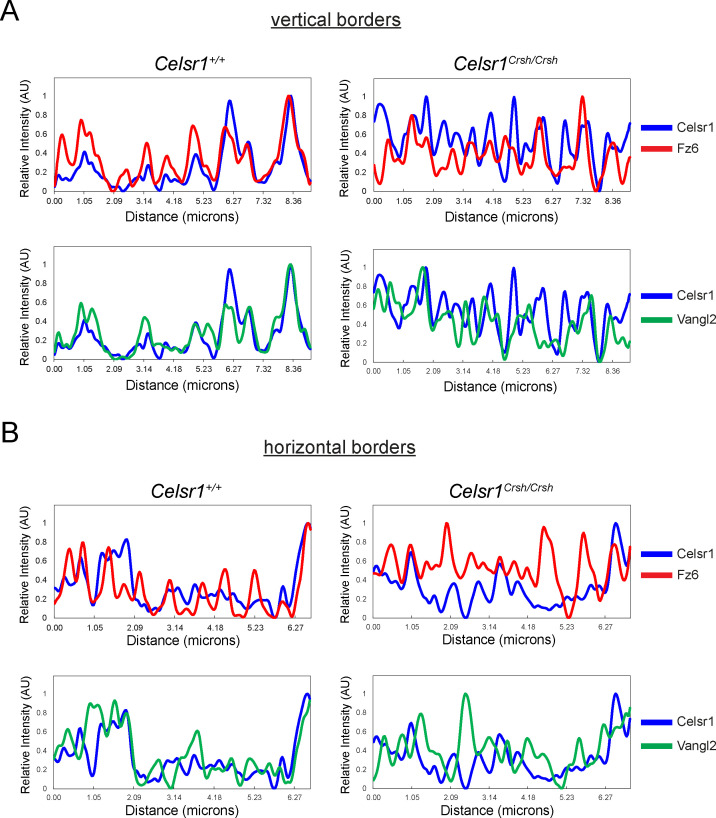
Planar cell polarity (PCP) protein distribution along cell borders in vivo.Fluorescence intensity measurements of lines drawn along vertical (A) and horizontal (B) borders in E14.5 Celsr1+/+ and Celsr1Crsh/Crsh epidermis. See Figure 8—figure supplement 1 for corresponding images.